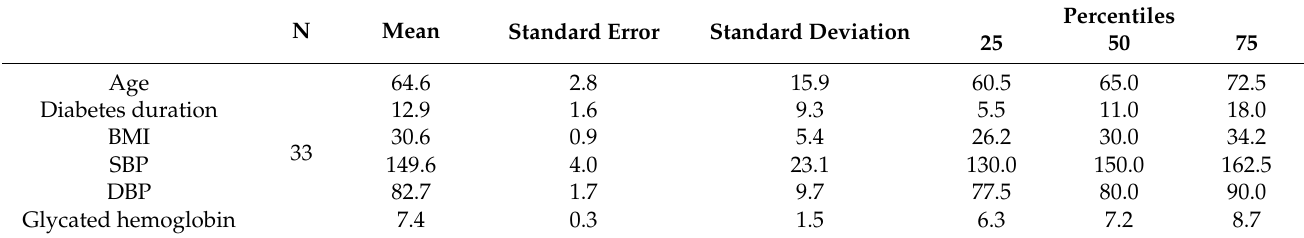
Table 1. The demographic and clinical characteristics of the